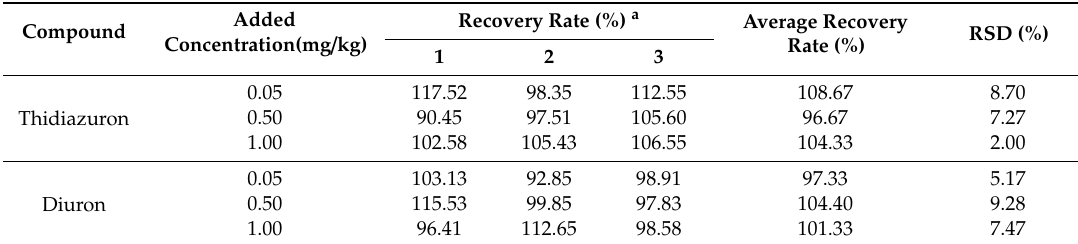
Table 3. Recovery rate of thidiazuron and diuron in cotton